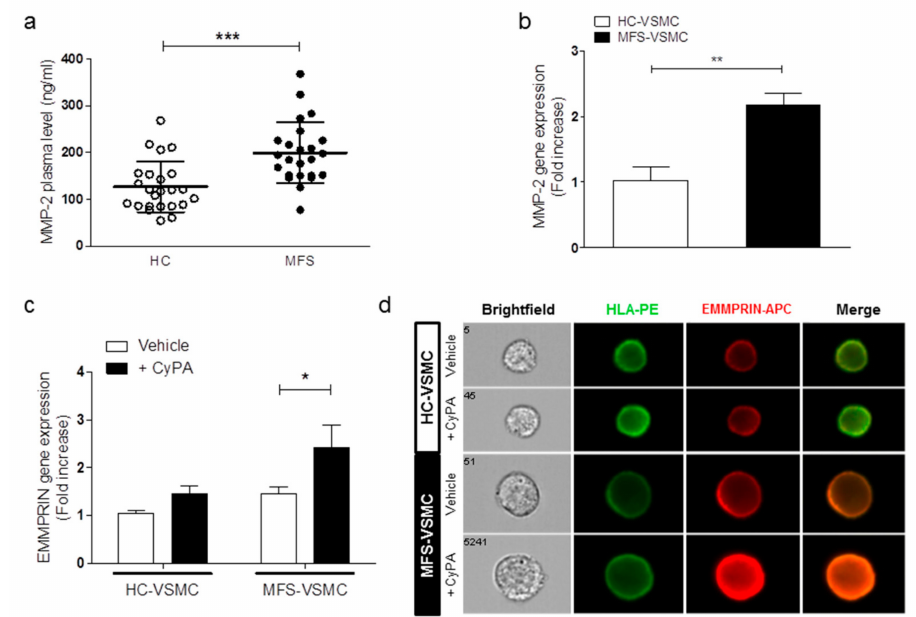
Figure 5. MMP-2 is up-regulated in MFS and exogenous CyPA promotes EMMPRIN gene and protein expression in MFS-VSMC. ( a ) ELISA assay on MMP-2 plasma levels of HC donors and MFS patients. Data are shown as mean ± SD, n = 24 / group. Student’s t -test: *** p < 0.0001. ( b ) MMP-2 gene expression in RNA extracts of HC-VSMC (white bars) and MFS-VSMC (black bars). qRT-PCR analyses have been performed in triplicate and data are shown as fold change ± SD, n = 5. Student’s t -test: ** p < 0.01. ( c ) EMMPRIN gene expression levels in HC-VSMC and MFS-VSMC, after 100 ng / mL CyPA treatment. qRT-PCR analyses have been performed three times in triplicate and data are shown as fold change ± SD, n = 5. * p < 0.05 ( d ) Representative images of immunofluorescence on HC-VSMC and MFS-VSMC, after 100 ng / mL CyPA treatment, in brightfield, HLA-PE antibody, EMMPRIN-APC antibody, and merge. Cell images have been generated in real-time by Amnis imaging flow cytometer ImageStreamX with a magnification of 40 ×